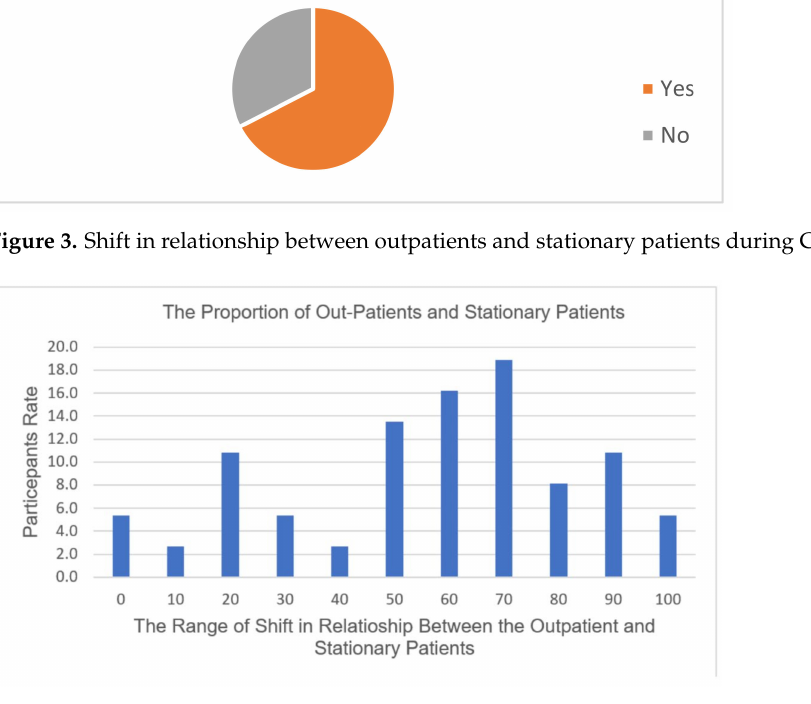
Figure 4. A total of 72.9% of participants assumed that the proportion increased from 50% to